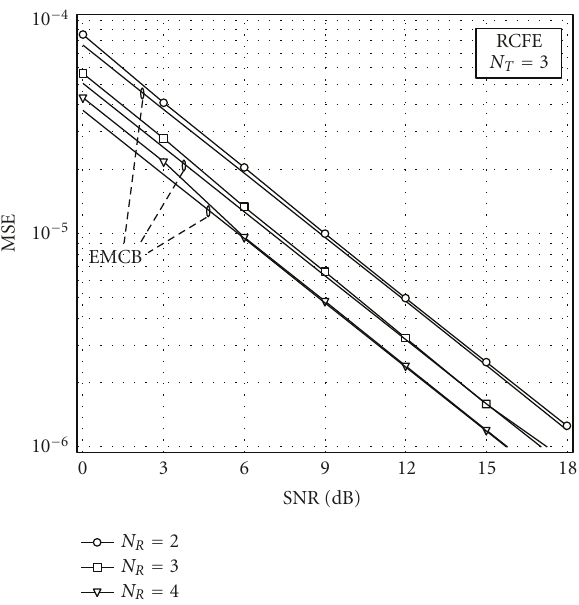
Figure 3: Accuracy of RCFE versus SNR with N T = 3 and N R =